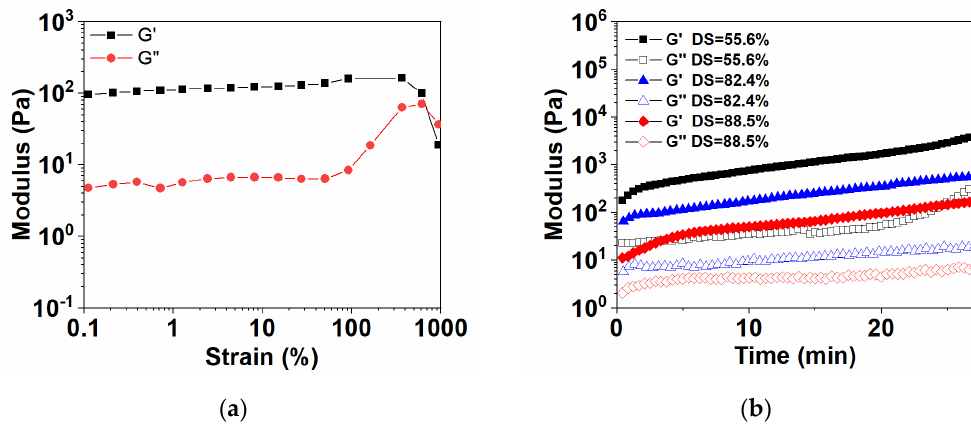
Figure 3. Rheometric tests of DACS hydrogels. ( a ) The amplitude sweep tests and ( b ) the time sweep tests at a frequency of 1 Hz and a strain of 1%.